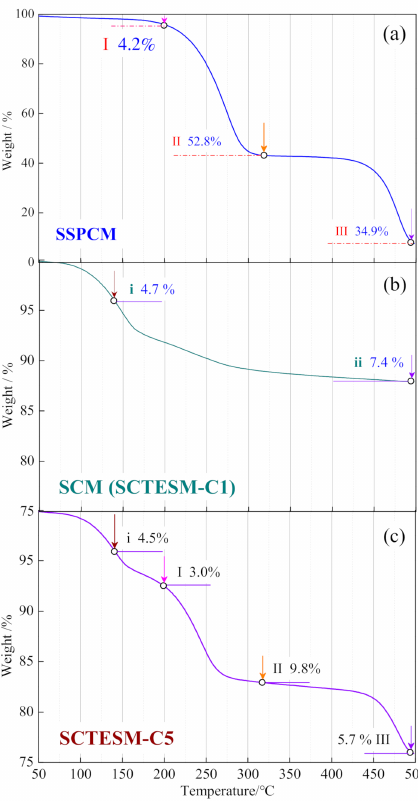
Figure 10. Thermogravimetric analysis curves: ( a ) SSPCM; ( b ) SCM; ( c )